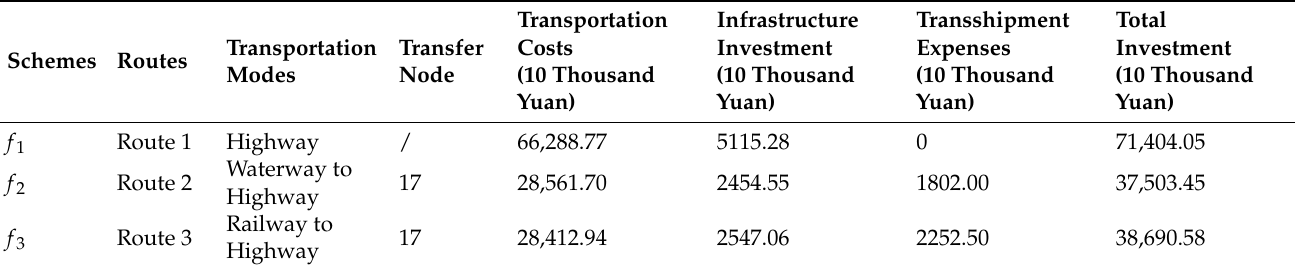
Table 3. The detailed information of each